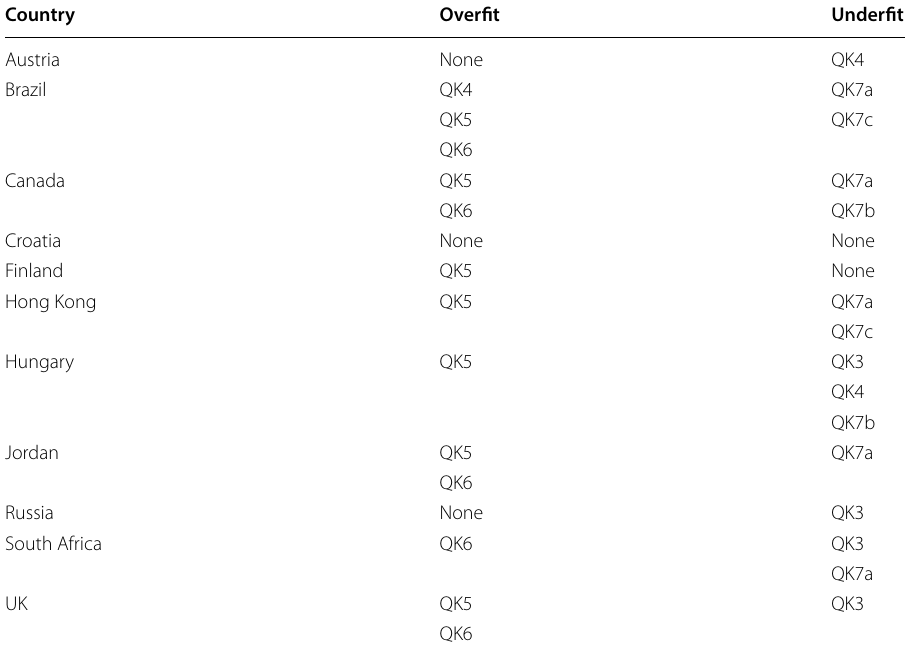
Table 6 Item Overfit and Underfit Assessment. Source: summarised from WINSTEPS ® output (Linacre 2017a)